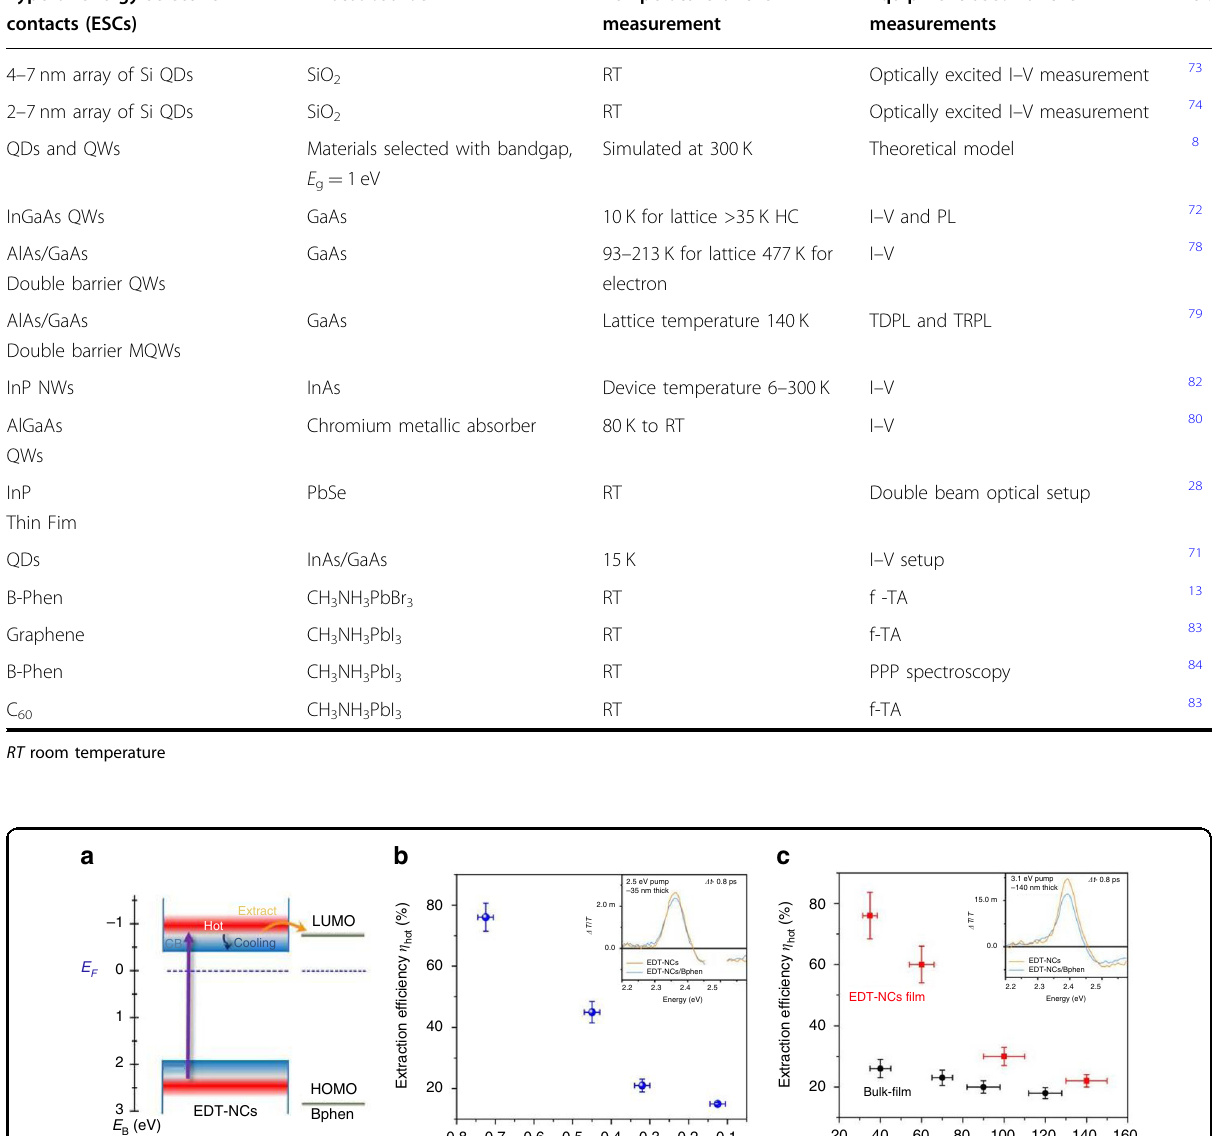
Table 2 Energy-selective contacts employed in various HC Type of energy-selective contacts (ESCs)